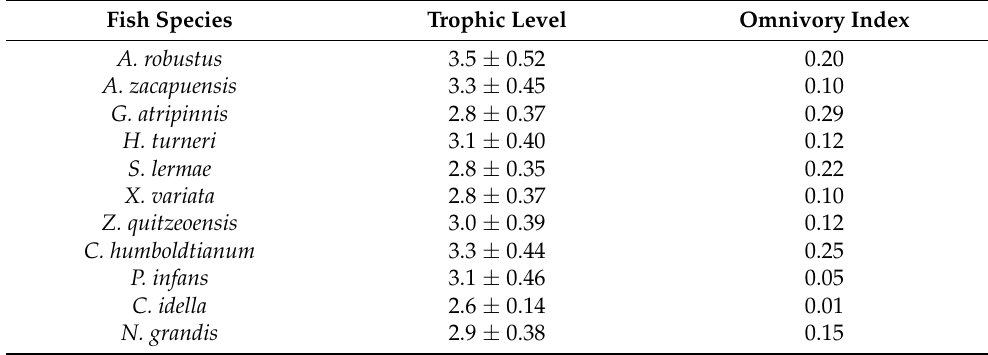
Table 3. Trophic level (average ± SD) and omnivory index for the fish species caught in Lake Zacapu. Fish Species Trophic Level